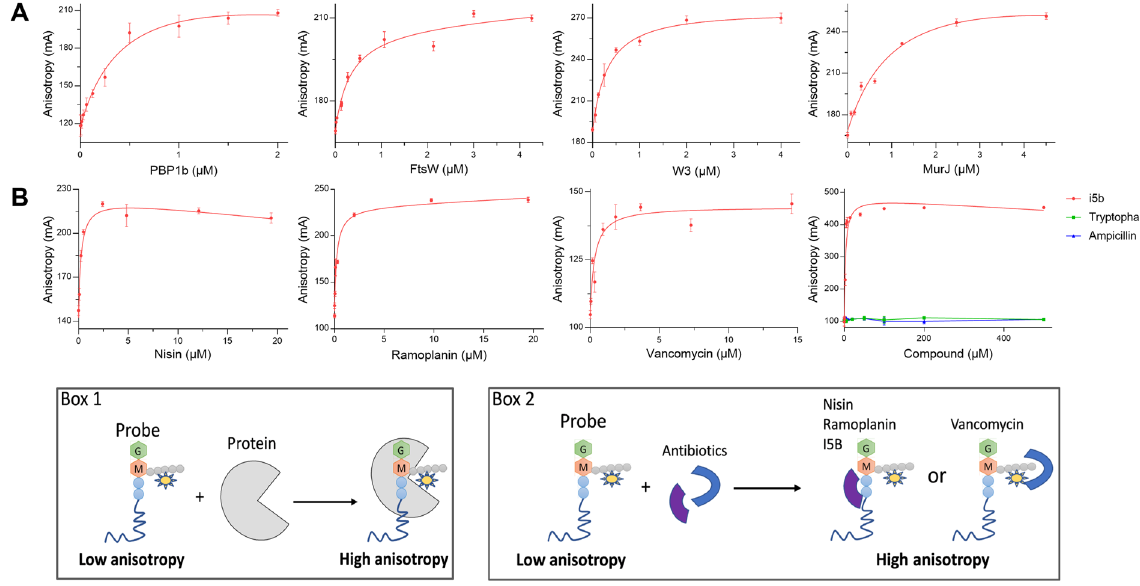
Figure 2. Fluorescence anisotropy assay using the NBD-lipid II as a probe for binding studies with proteins and antibiotics. FA (in mA units) is plotted as a function of protein or antibiotic concentrations. The error bars represent the FA values as mean ± s.d. of triplicate experiments using the same buffer and protein conditions. ( A ) Direct binding of NBD-lipid II probe (0.33 µ M) to PBP1b, FtsW, FtsW-PBP3 complex and MurJ. ( B ) Direct binding of NBD-lipid II probe (0.33 µ M) to different antibiotics (nisin, ramoplanin, vancomycin, and the small molecule I5b. The last panel also shows that tryptophan and ampicillin used as controls do not bind to the probe. Box 1 and Box 2 schematically illustrates the corresponding FA assay and the observed FA